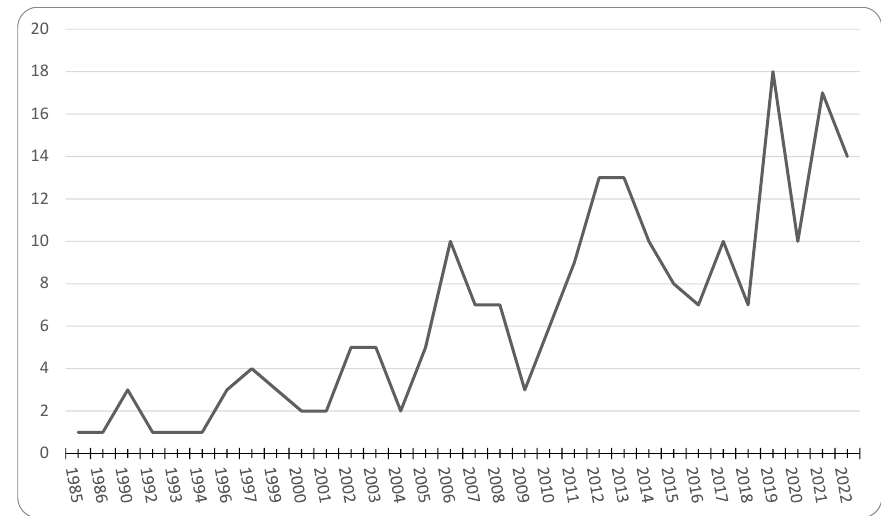
Figure 1. Number of Publications Comparing native- and foreign-born Blacks, By Year.